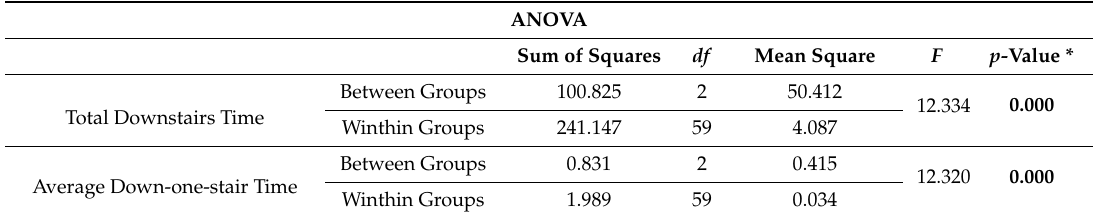
Table 5. ANOVA test of downstairs walking for the three groups.